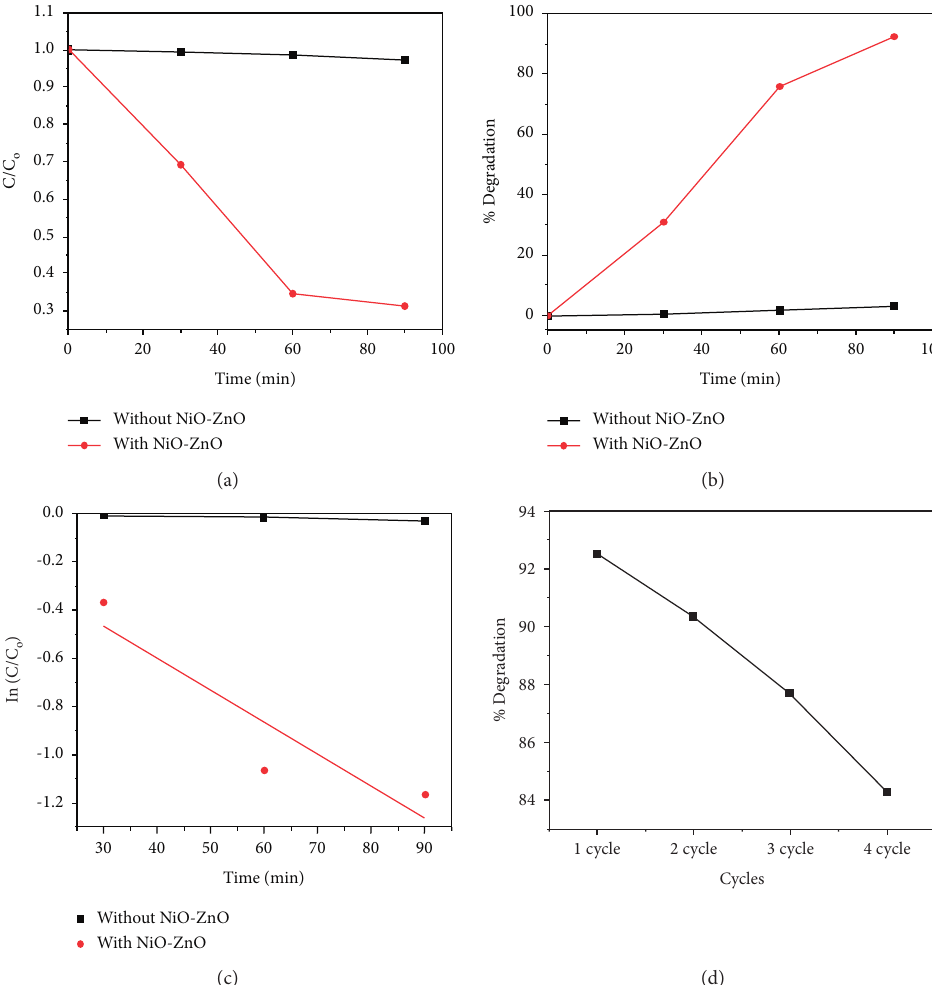
Figure 8: Photodegradation of BG. (a) Degradation profile, (b) percent degradation, (c) kinetic isotherm, and (d) reusability data.